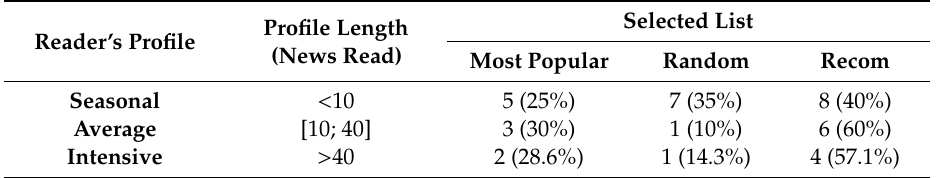
Table 2. Experiment 1: Influence of the reader’s consumption frequency on list selection–absolute (relative) frequencies. Profile Length Reader’s Profile